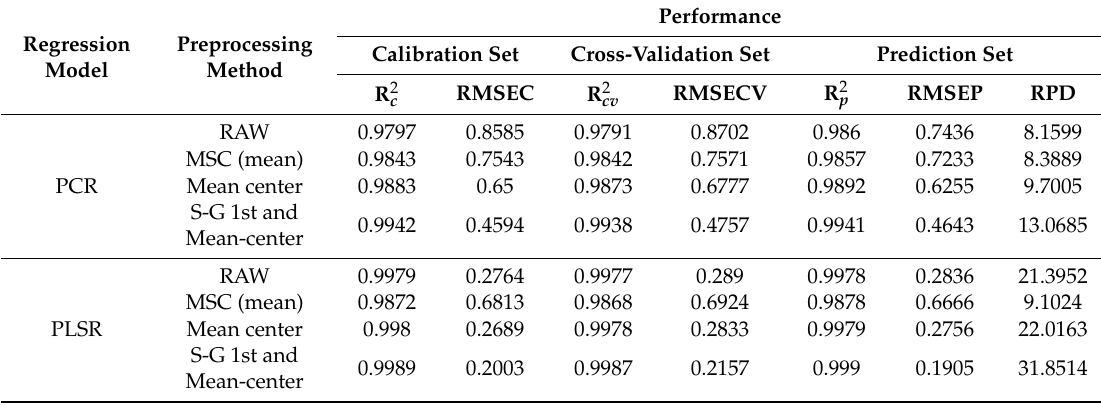
Table 6. Prediction performances of di ff erent regression models based on the NIRS data.